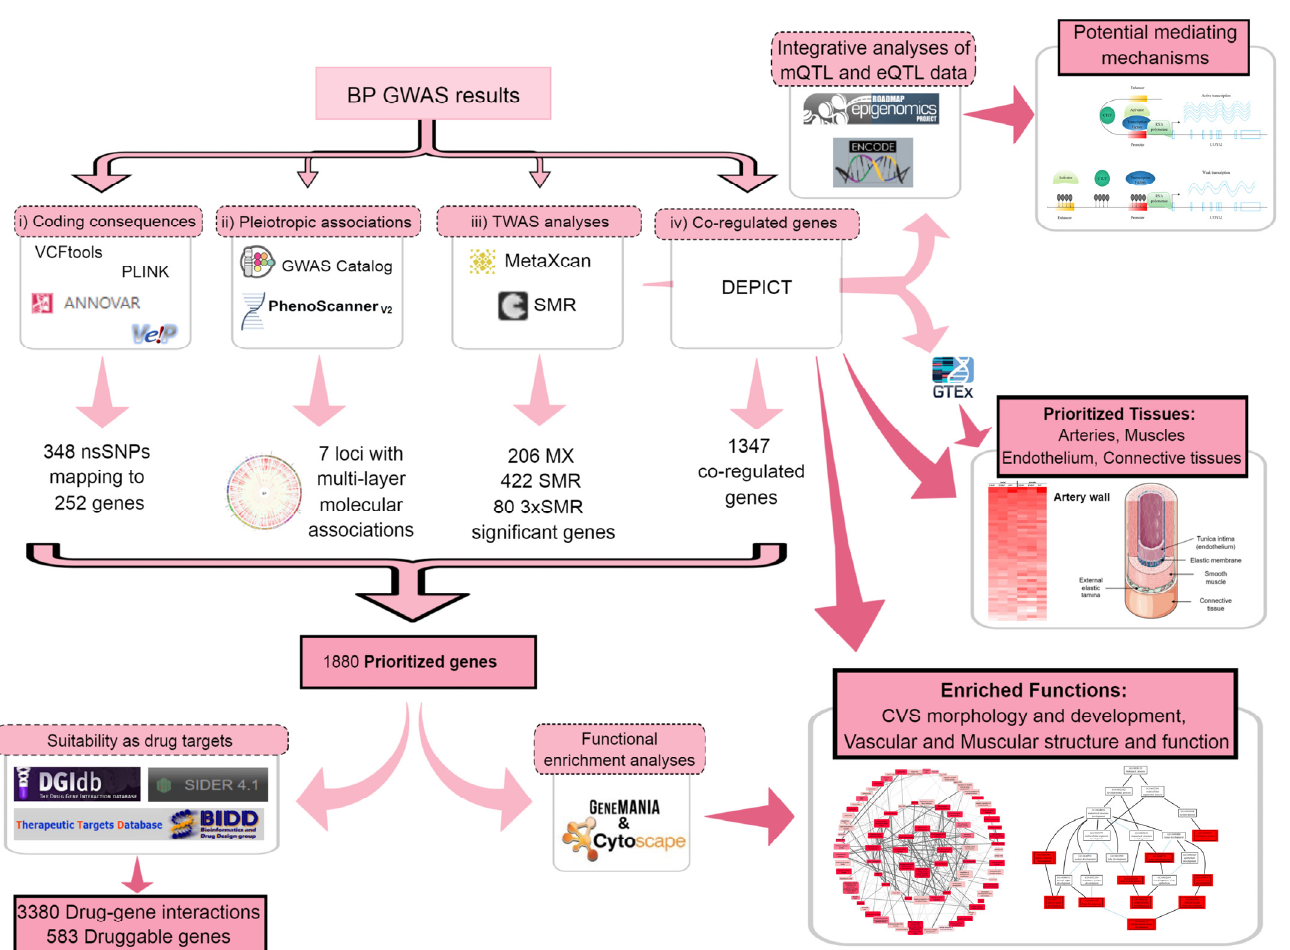
Figure 1. Summary of the methods as well as the main results of prioritization and follow-up analyses using blood pressure GWAS summary statistics. Pink boxes with dashed borders represent methods and their underlying boxes with gray border detail the tools. Pink boxes with solid black borders represent results and their underlying boxes with gray border provide small pictures of results. High resolution figures of heatmap and graphs can be found at the results section. BP: blood pressure; GWAS: genome-wide association study; TWAS: transcriptome-wide association study; nsSNPs: nonsynonymous single nucleotide polymorphisms; MX: MetaXcan; SMR: summary data-based Mendelian randomization; mQTL: methylation quantitative trait loci; eQTL: expression quantitative trait loci; CVS: cardiovascular system.